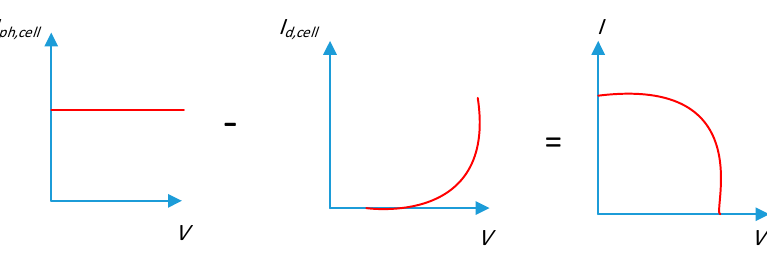
Figure 3. Photovoltaic voltage and current curve.